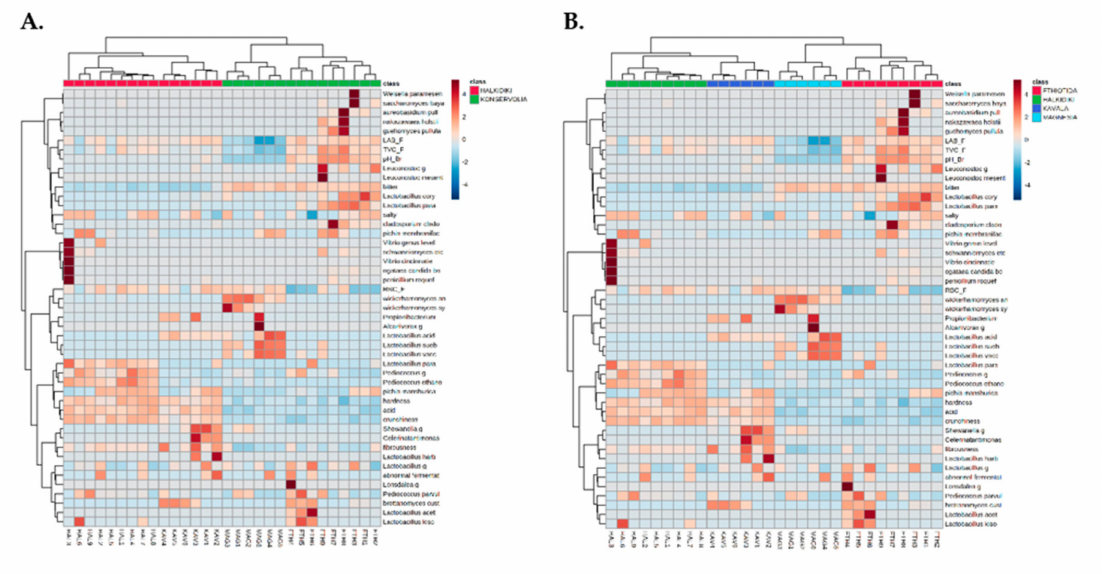
Figure 7. Hierarchically clustered heatmap of microbiological, physicochemical, organoleptic, and species level operational taxonomic units (OTUs) of bacteria and yeast communities data of table olive samples based on ( A ) the cultivar and ( B ) the geographical origin of the samples. The sample codes are indicated in Table